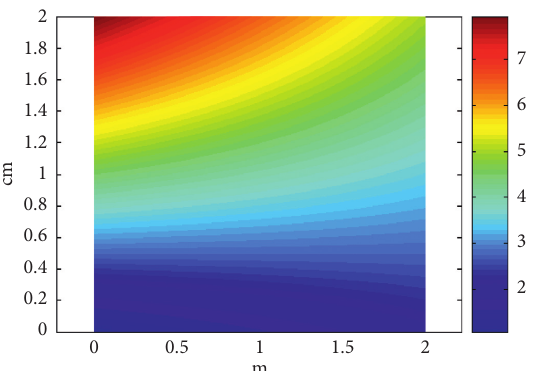
Figure 5: Processing map of distance between surface working face and cut hole in subsidence area ( d � 80cm).